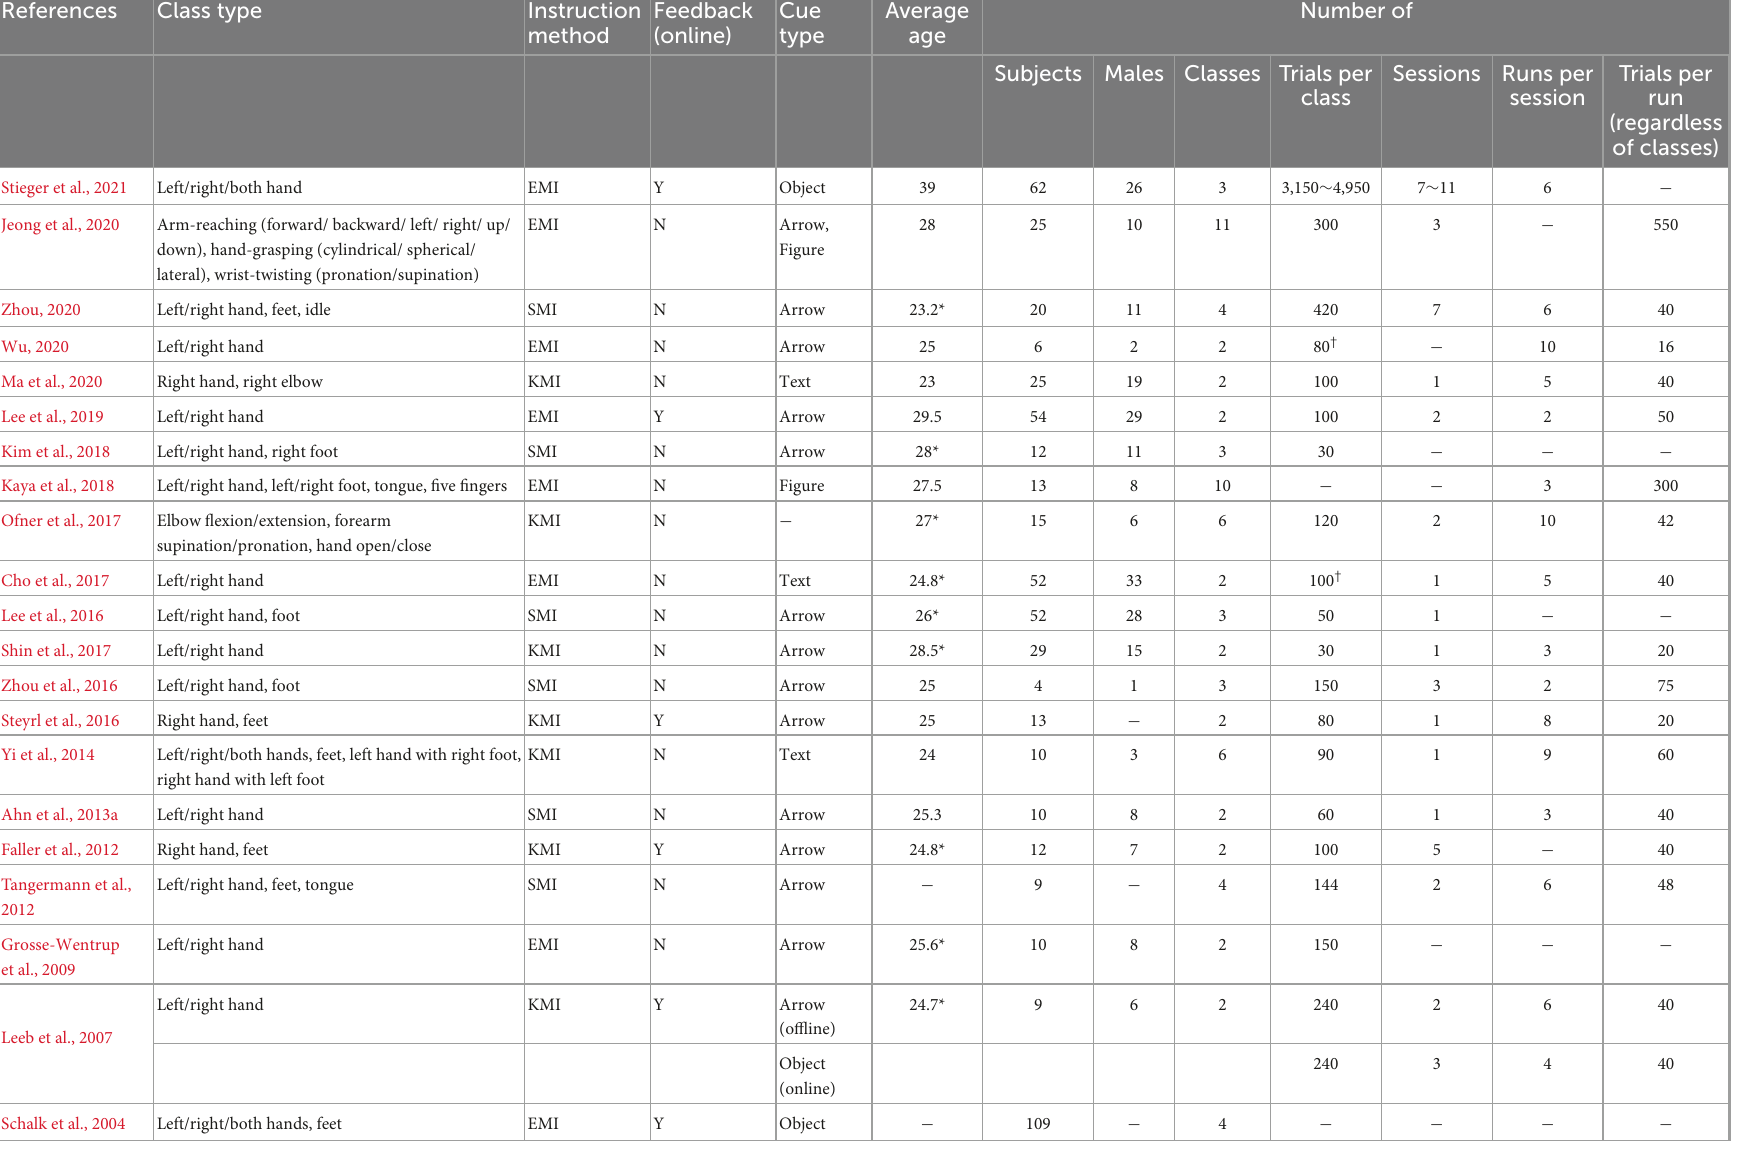
TABLE 2 Experiment specifications of motor imagery datasets (–: no information